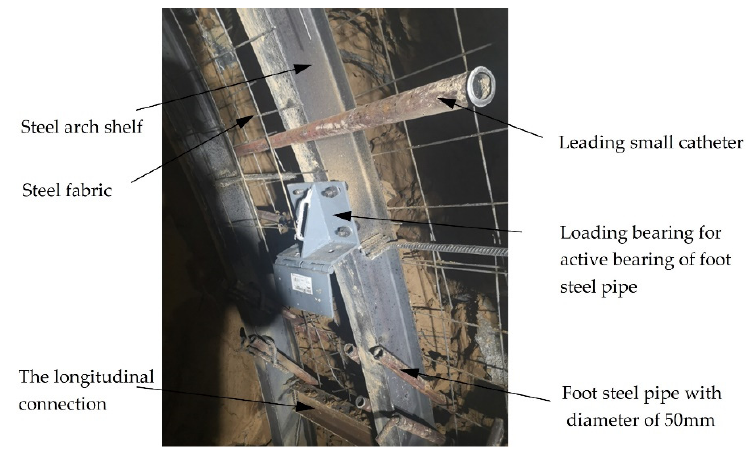
Figure 22. Effect drawing of loading support installed on a tunnel arch.